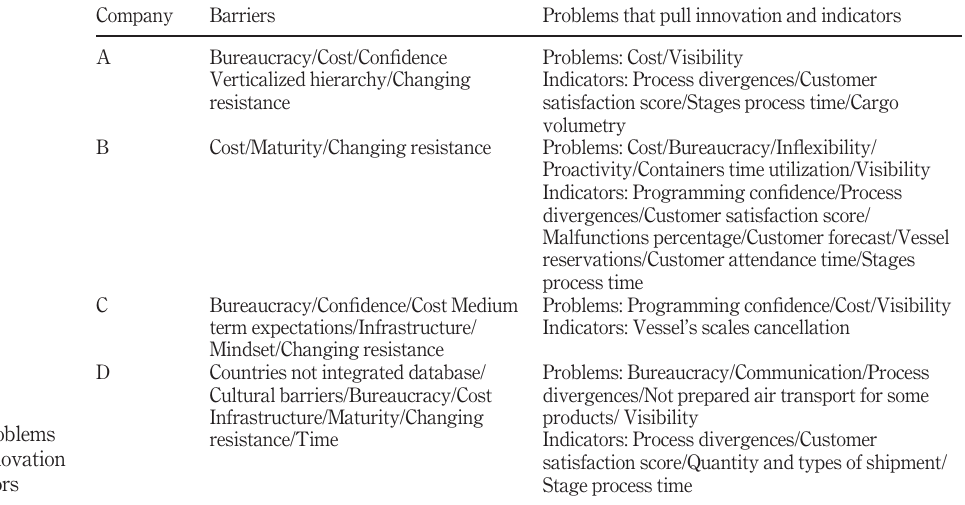
that pull innovation and